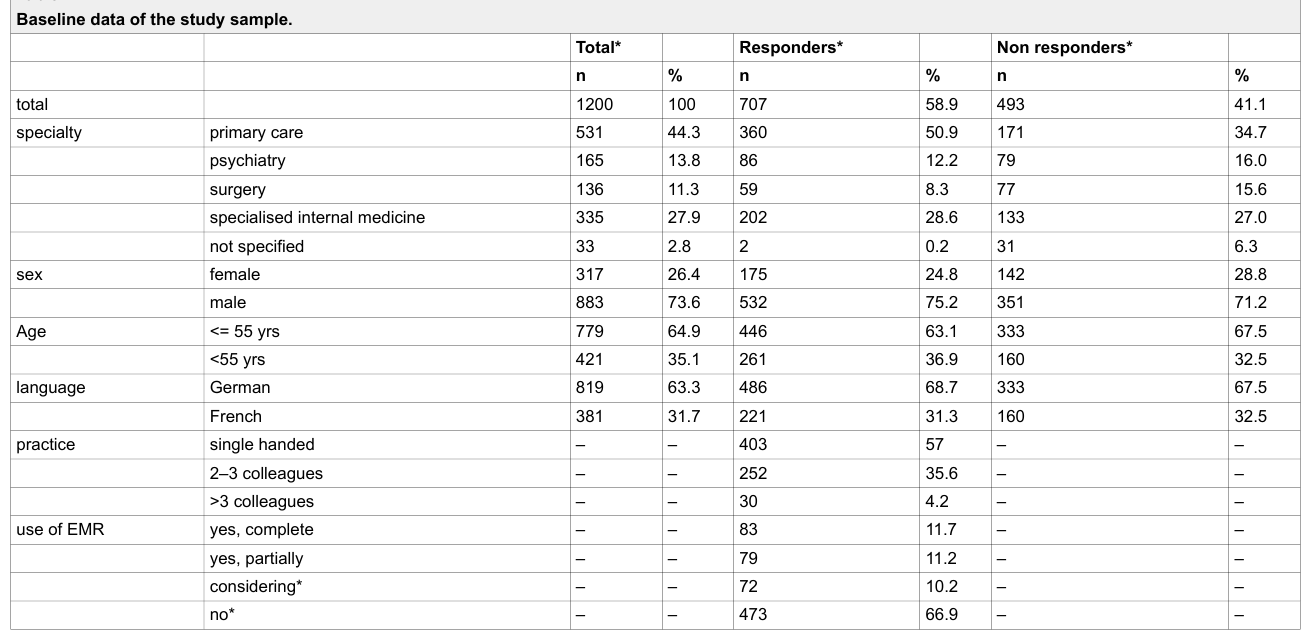
Table 1 Baseline data of the study